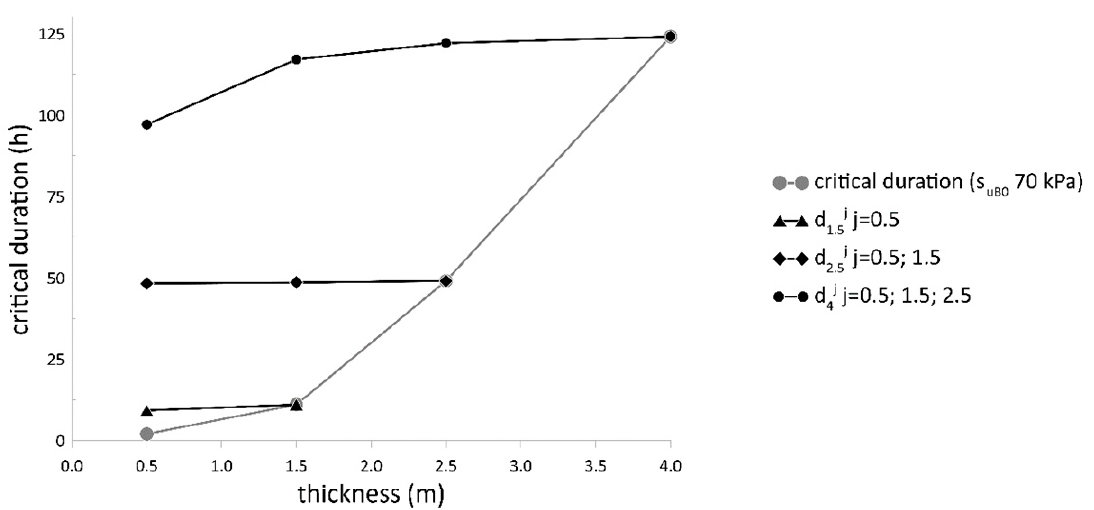
Figure 14. Results of set B analyses: critical duration against subdomain thickness computed for s uB0 = 70 kPa.